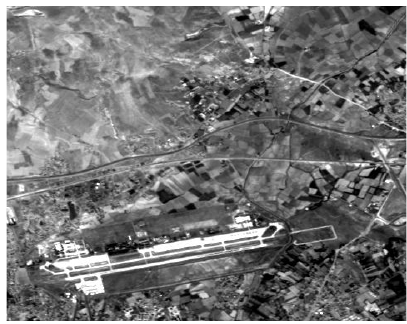
Figure 1: Red band of Rasat test image.